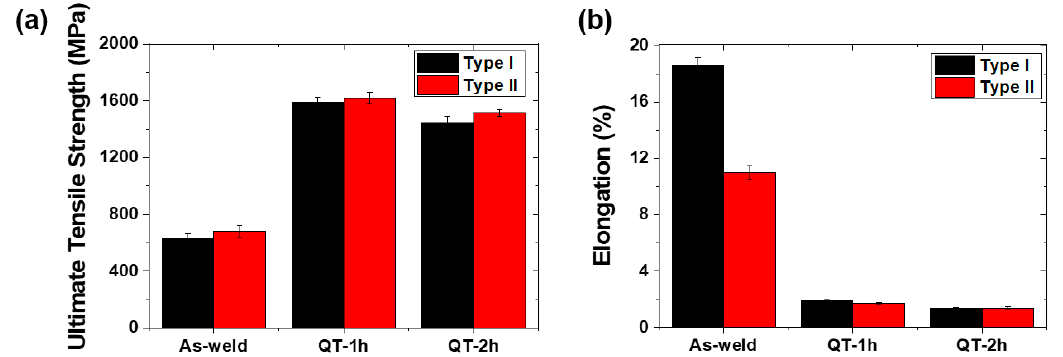
Figure 7. ( a ) Ultimate tensile strength and ( b ) elongation to fracture determined from the uniaxial tensile test for the laser-arc hybrid weld joints.